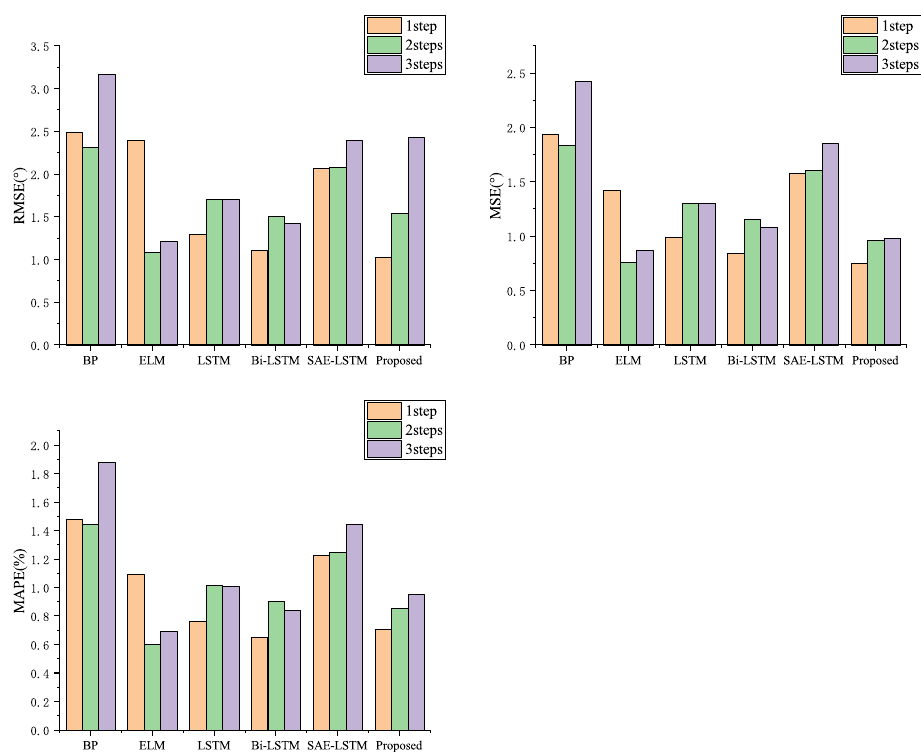
Figure 22. Pitch angle prediction error distribution of Dataset